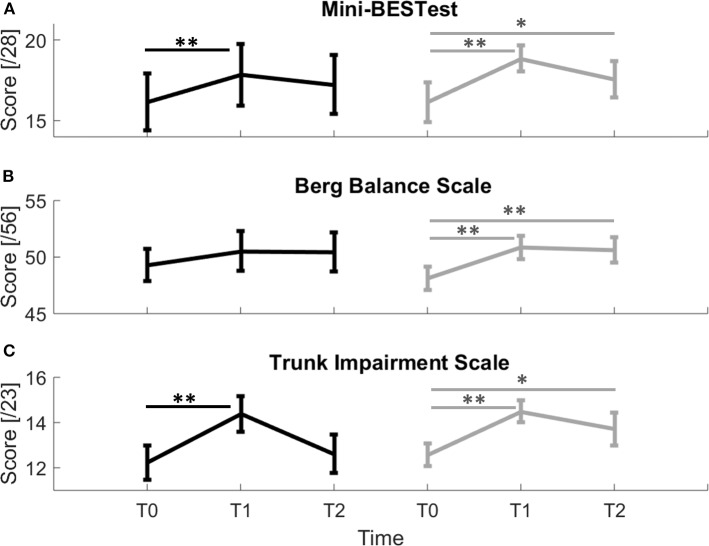
Clinical scales scores for control (black line) and experimental (gray line) groups. (A) Mini-BESTest; (B) Berg Balance Scale; (C) Trunk Impairment Scale. Error bars indicate Standard Error; * indicate a p-value between 0.01 and 0.05, while ** indicate p < 0.01.